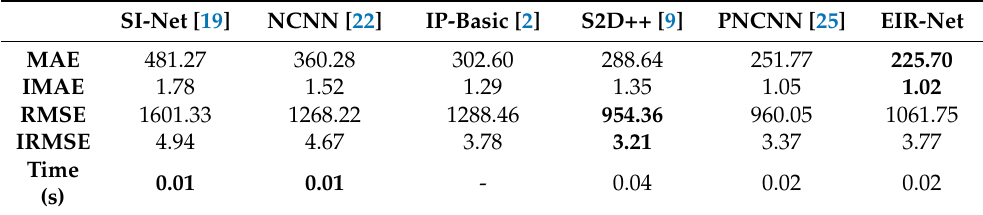
Table 1. Comparisons to other methods without RGB image guidance on KITTI. The bold numbers are the best.